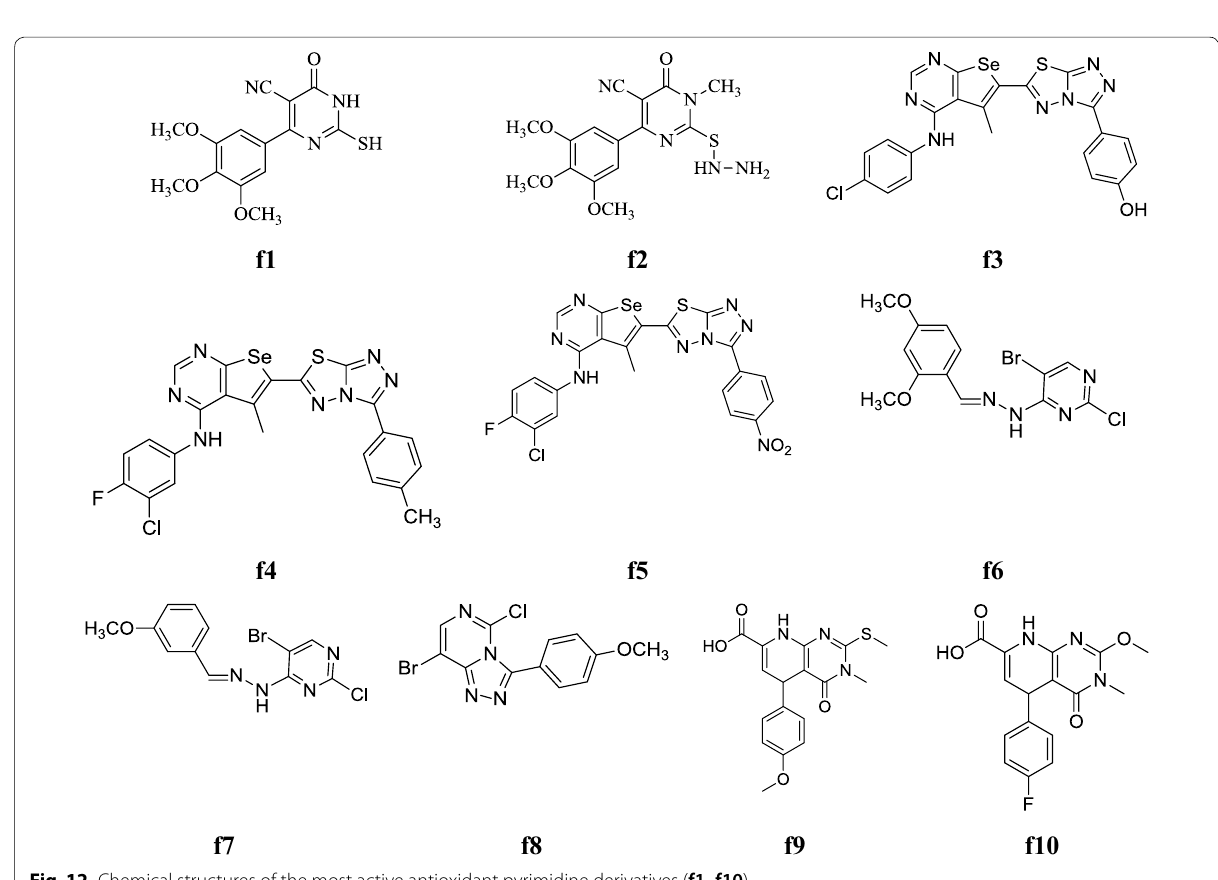
Fig. 12 Chemical structures of the most active antioxidant pyrimidine derivatives ( f1 – f10